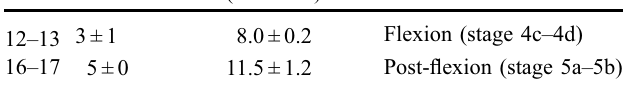
Table 1. Days-post-hatch (DPH), number of turbot larvae studied for each recording, larval standard length ( fl exion n = 23; post- fl exion n =16), larval developmental stages (after Al-Maghazachi and Gibson,